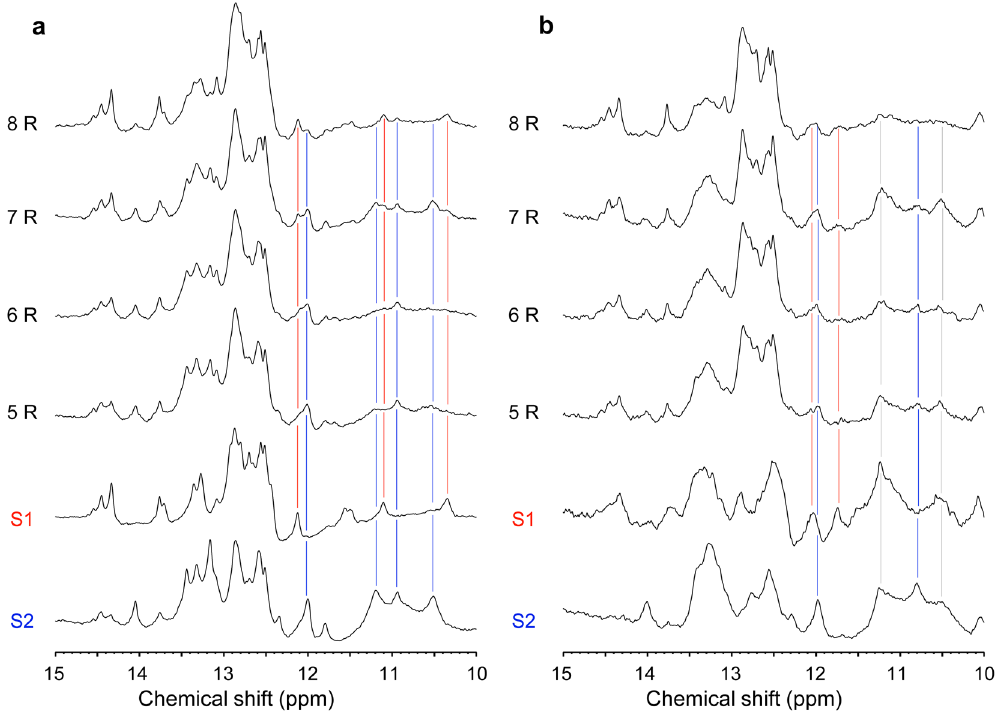
Figure 5. Comparison of 1D imino proton spectra between RNA pools from SELEX, S1, and S2. Comparison of 1D imino proton spectra of 5–8R RNA pools with those of S1 (red) and S2 (blue) in the absence ( a ) and presence ( b ) of RD. Red and blue lines indicate discriminative imino proton signals of S1 and S2, respectively; gray lines indicate those common to both S1 and